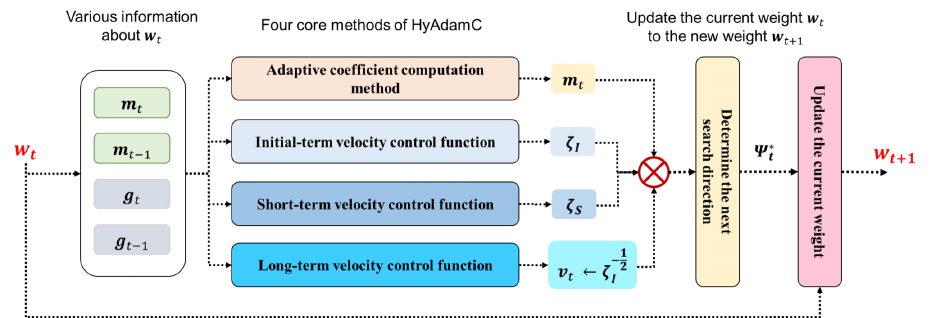
Figure 3. The overall architecture of HyAdamC and its hybrid